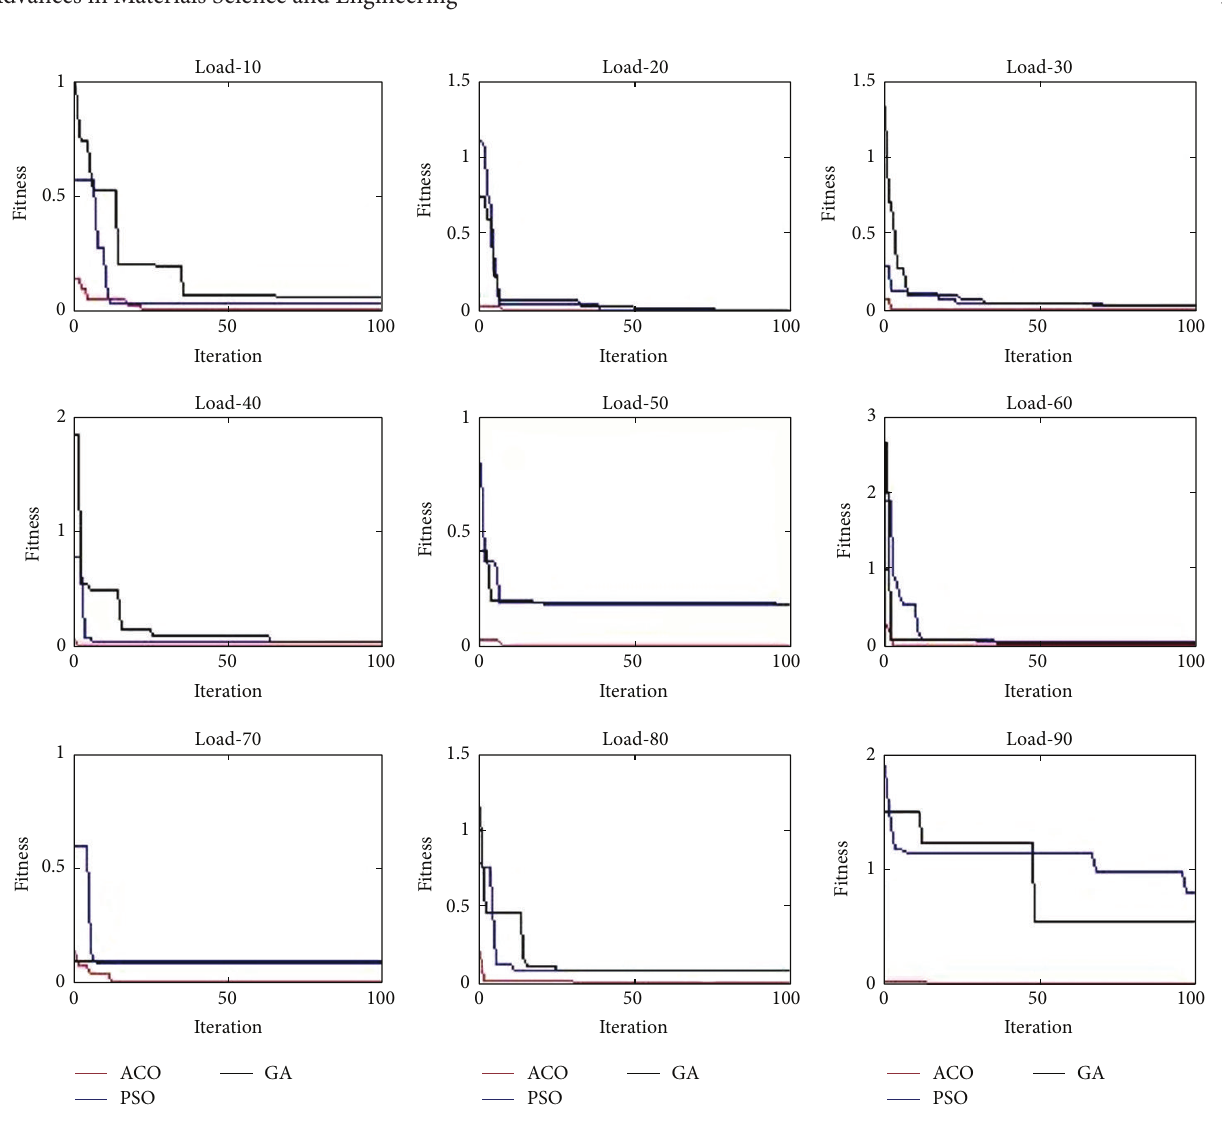
Figure 7: Convergence graph of